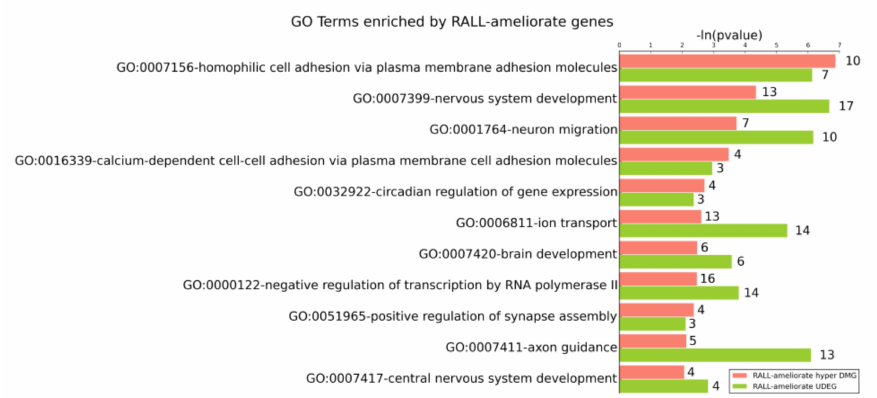
Figure 7. Gene ontology enriched by DR-ameliorated UDEGs and DR-ameliorated hyper DMGs. The − ln( p -value) and the number of genes in the GO terms are shown. The salmon-colored bars represent the GO terms enriched by DR-ameliorated hyper DMGs, while the olive-colored bars represent the GO terms enriched by DR-ameliorated UDEGs.